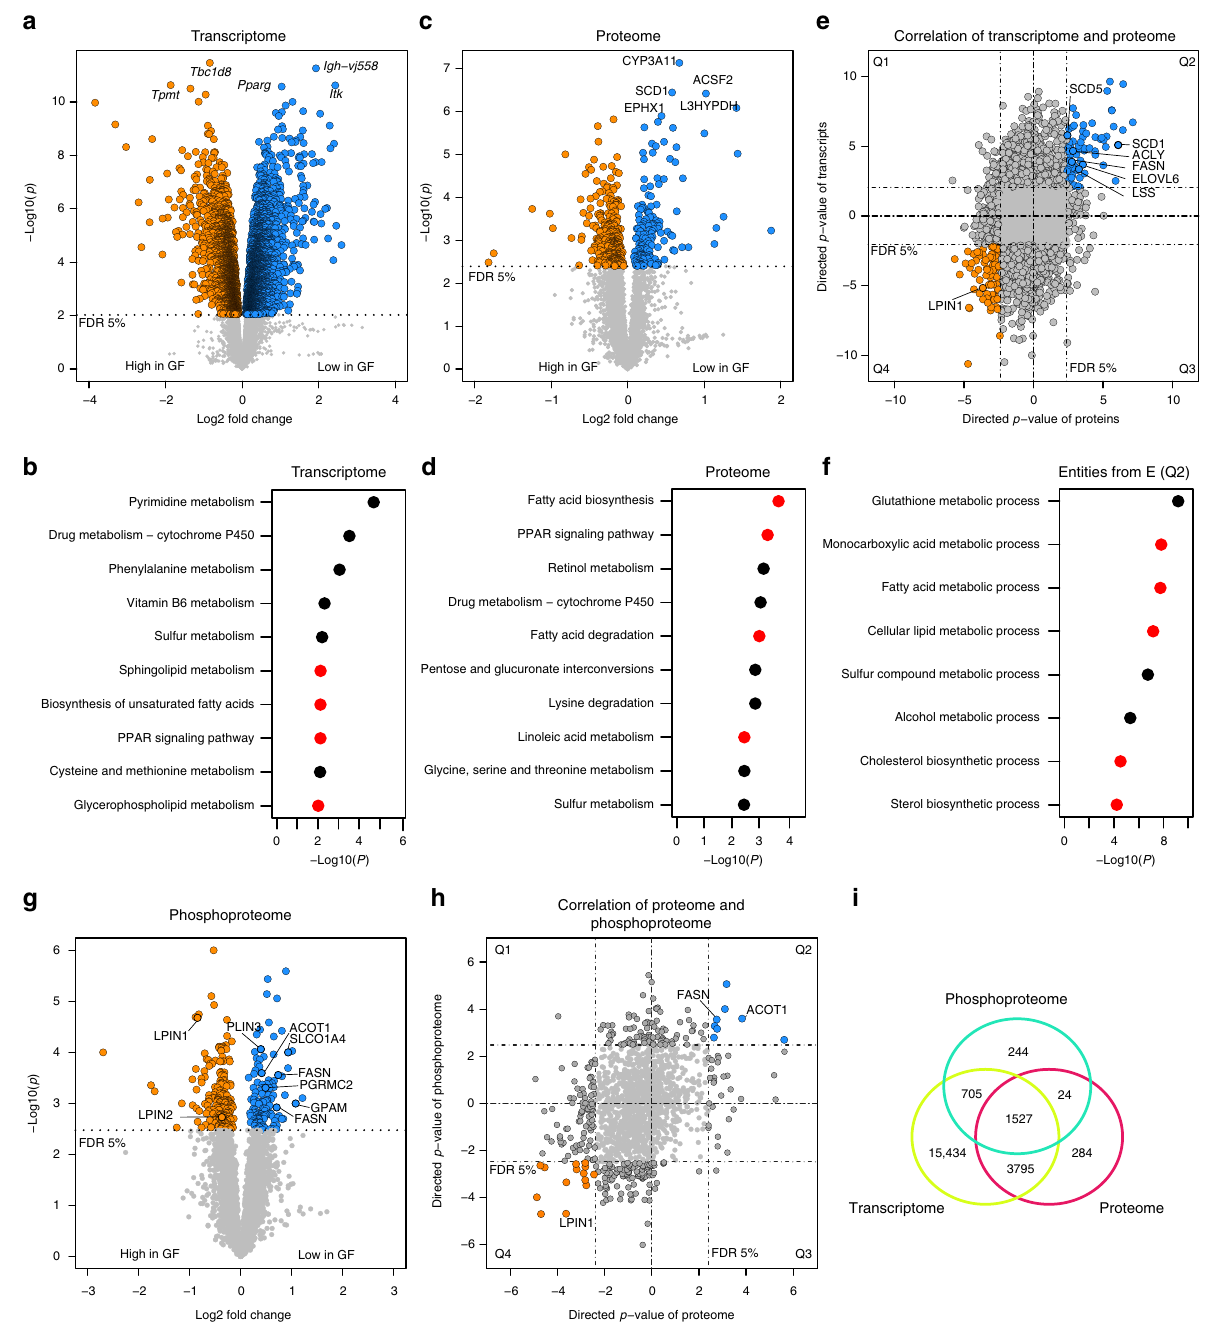
Fig. 1 Transcriptomic, proteomic, and phosphoproteomic analyses of liver samples from SPF and GF mice. a Transcriptome data analyzed by t -tests, ( n = 6/6). b KEGG pathway enrichment on transcriptome data. c Proteome data, analyzed by t -tests, ( n = 5/5). d KEGG pathway enrichment in proteome data. e Transcriptome – proteome correlation. f GO enrichment analysis for biological processes of Q2 from e . g Phosphoproteome analyzed by t -tests, ( n = 5/5). h Proteome – phosphoproteome comparison. i Venn diagram showing the overlap of detected genes, proteins, and phosphoproteins. e , h Q1, Q2, Q3, and Q4 mark the quadrants of the correlation plots; directed p -values are de fi ned as – log 10 ( p ) times the direction of the effect. b , d , f Red dots indicate lipid- related pathways. FDR: false discovery rate, GF: germfree, SPF: speci fi c pathogen-free Phosphoproteome pro fi ling . Protein phosphorylation plays an important role in the activation and deactivation of enzymes. eight proteins were involved in lipid metabolism: ACOT1 (hydrolysis of acyl-CoA), FASN, GPAM (glycerolipid synthesis), LPIN1/2 (phosphatidic acid phosphatases), PGRMC2 (steroid binding), PLIN3 (lipid droplet coat protein) and SLCO1A4 (bile acid transport). After combining protein and phosphoprotein NATURE COMMUNICATIONS| (2018) 9:3760 |DOI: